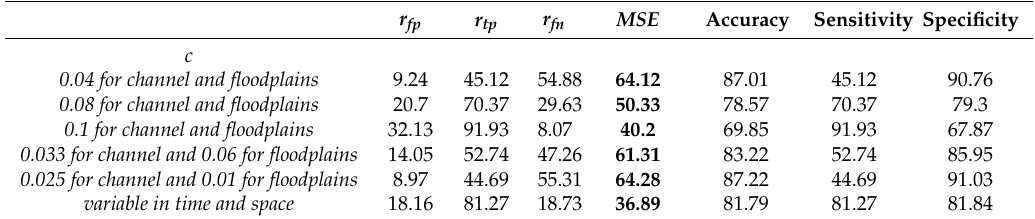
Table 7. Results of hydraulic simulation model calibration performance for 3 December 2013 in terms of a flood extent map: the set of Manning coefficients c , false positive rate r fp , true positive rate r tp , false negative rate r fn , minimized sum of errors ( MSE ), and accuracy, sensitivity, and